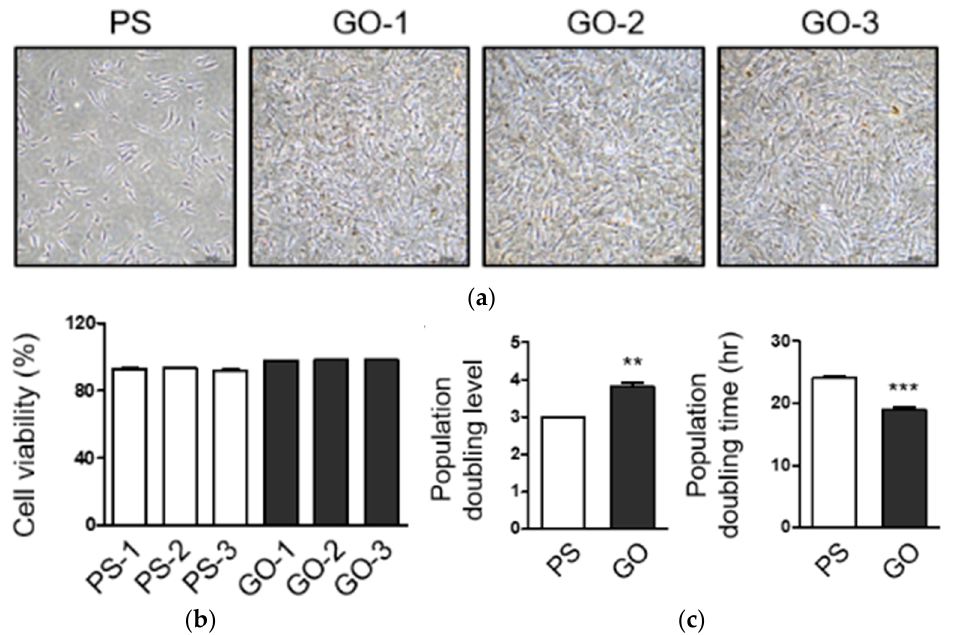
Figure 10. Morphology and cell proliferation of hBM-MSCs on PS and GO substrates. Morphology of hBM-MSCs on PS and GO substrates ( a ) Cell viability of hBM-MSCs ( b ) Population doubling level and population doubling time of hBM-MSCs ( c ) Growth of cells increased by about 27% in cells of GO substrates compared to PS substrates. Data are presented as the means ± SDs, ** p < 0.01, *** p < 0.001 versus control (PS).